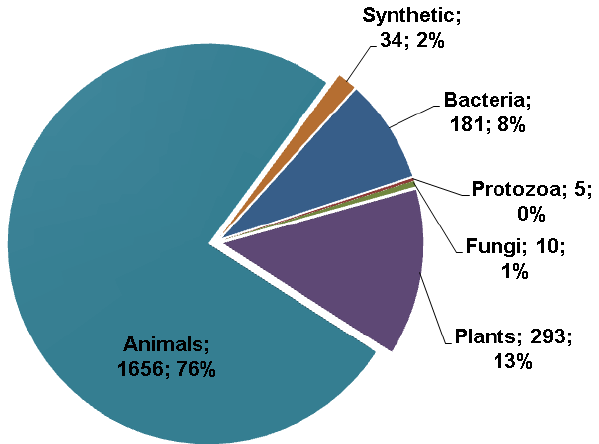
Figure 1. Sources of antimicrobial peptides (in total: 2183) in the antimicrobial peptide database [8,9] in March 2013. The three major sources are animals (76%), plants (13%), and bacteria